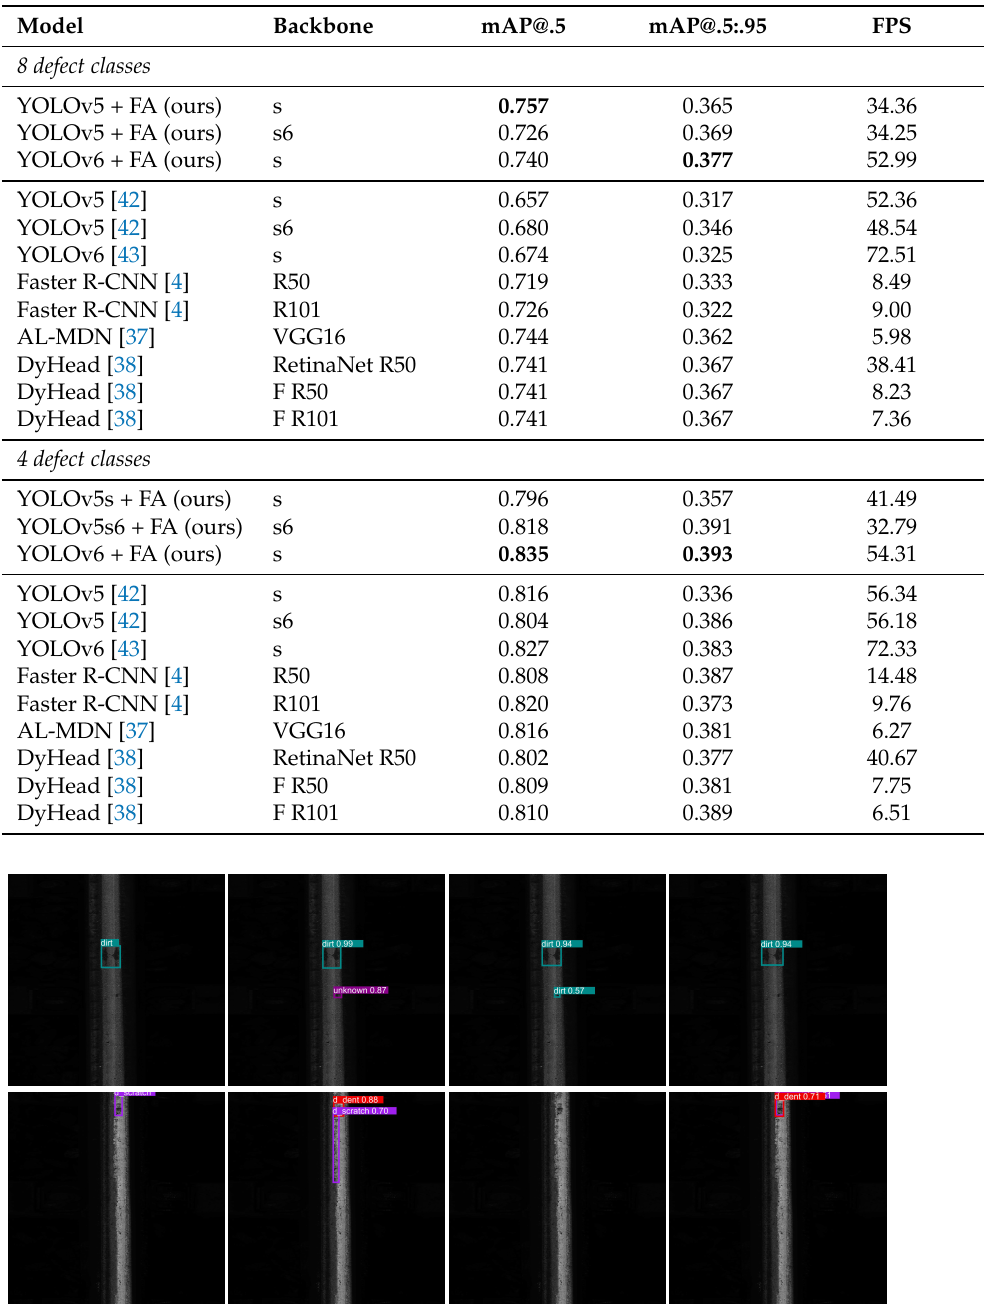
Table 3. Detection results of different methods over the rail defect test dataset.